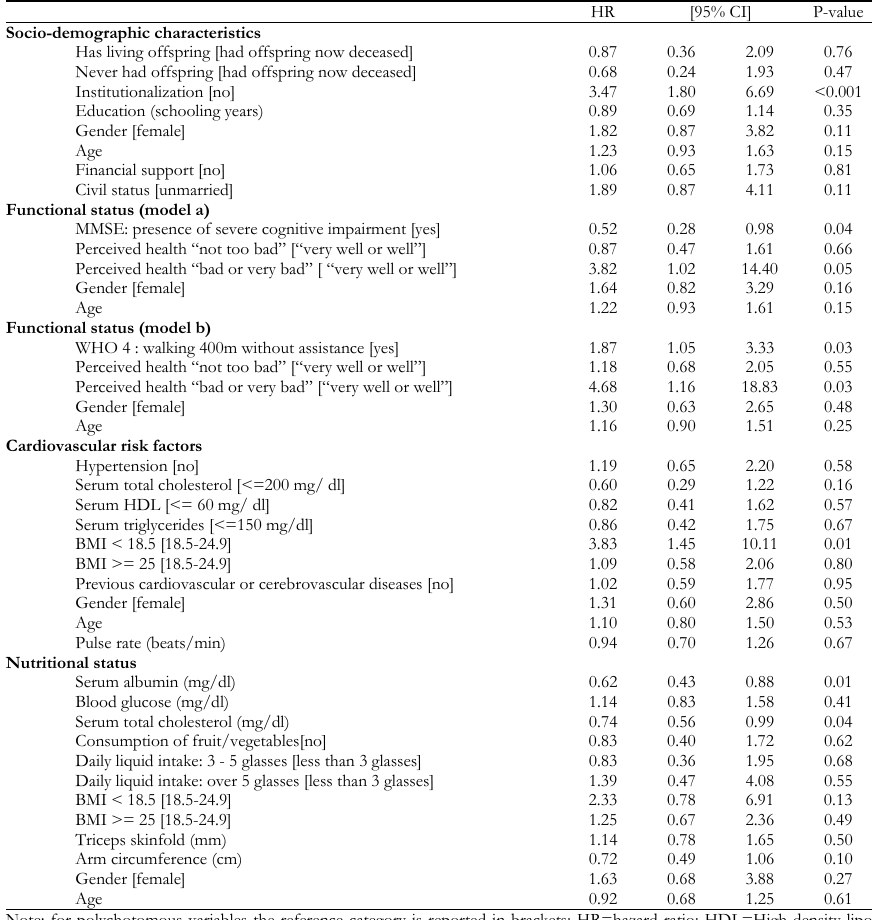
Variables predicting survival after 98 years of age. Models for group of prognostic factors